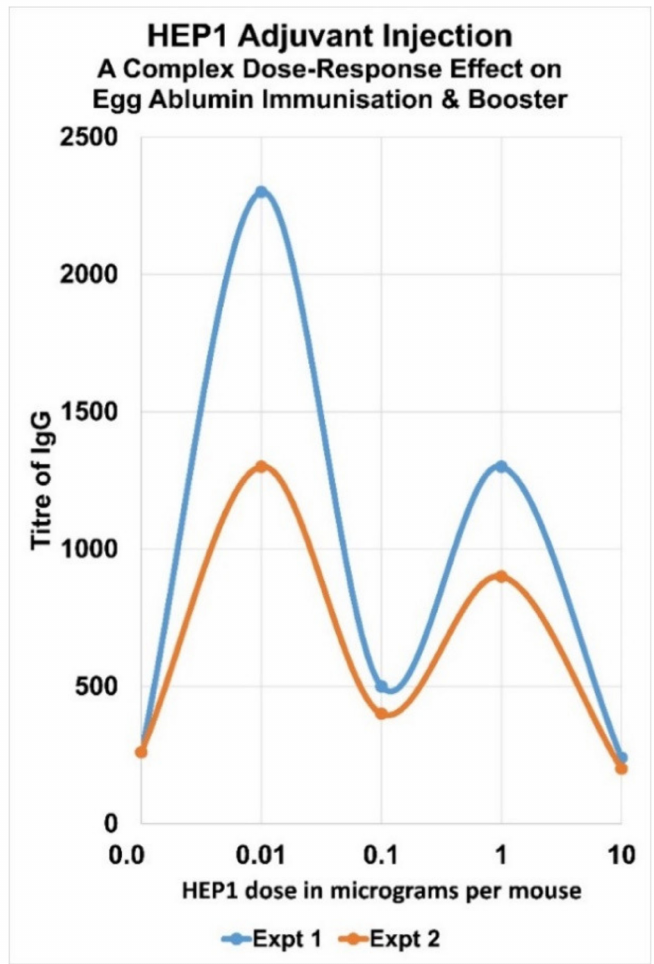
Figure 11. Two separate experiments demonstrated the complex dose-dependence of the adjuvant effect of HEP1 adminstered at 0.01, 0.1, 1 and 10 µ g per mouse. This adjuvant activity of HEP1 was demonstrated in mice immunised and boosted with 50 µ g of soluble heterologous egg albumin EA antigen simultaneously with HEP1, to produce serum IgG antibodies. The immune response 7 days after immunisation and booster with EA antigen, was expressed as ELISA IgG titre, plotted by